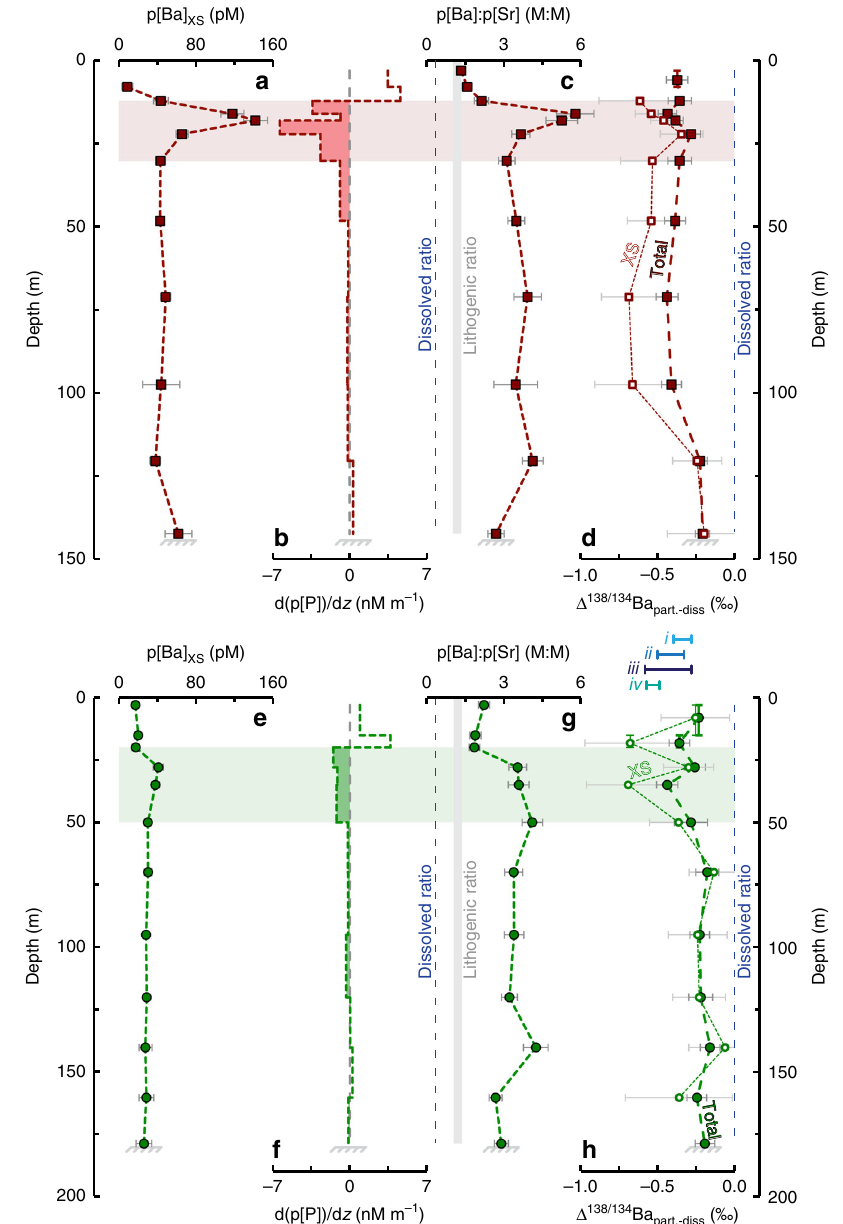
Fig. 3 Characterization of the pBa excess in Lake Superior. a – d from St. FWM; e – h from St. WM. Depth pro fi les of a , e p[Ba] XS ; b , f fi rst derivative of p[P] with respect to depth, illustrating that the depths and magnitude of most intensive organic matter attenuation are correlated with the depths and magnitude of pBa XS ; c , g particulate Ba:Sr ratios, also shown are the dissolved (dashed line) and average crustal ratio (vertical bar); d , h Ba-isotopic data expressed as the difference from dissolved Ba-isotopic compositions; Δ 138/134 Ba part. − diss. = δ 138/134 Ba part. − δ 138/134 Ba diss. . Isotopic fractionation factors between particulate and dissolved Ba are shown as i , ii , iii , and iv for: inorganic barite precipitation 30 , mean Lake Superior p[Ba] XS (this study), regression of seawater data 31 – 33 , and marine particles from the upper water column of the South Atlantic (Supplementary Fig. 7), respectively. Vertical error bars on the shallowest samples in d , h denote depth ranges over which particulate samples were pooled to obtain suf fi cient Ba for isotopic analysis. Horizontal error bars for any given property measurement re fl ect the propagated 2 × SD uncertainty. Shaded region highlights depth interval over which organic matter attenuation exceeds − 1 nM P m − for pBa XS — are isotopically lighter than total dissolvable (i.e., dissolved) Ba at both stations (Fig. 2d, h), with a similar average offset observed here ( Δ 138/134 Ba XS − diss. = − 0.41 ± 0.09 ‰ ) to that observed between dissolved Ba in seawater and barite- bearing particulates from the open ocean ( Δ 138/134 Ba part.